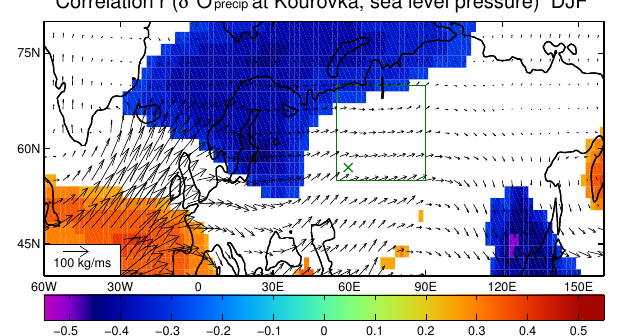
Figure 8. One-point correlation map showing the correlation be- tween δ 18 O in precipitation at Kourovka and sea-level pressure dur- ing winter (DJF, correlation period is 1960–2010). Also shown is the average atmospheric moisture transport during DJF (vectors; only every second vector is drawn). The green box indicates western Siberia and the position of Kourovka is marked by a green cross.